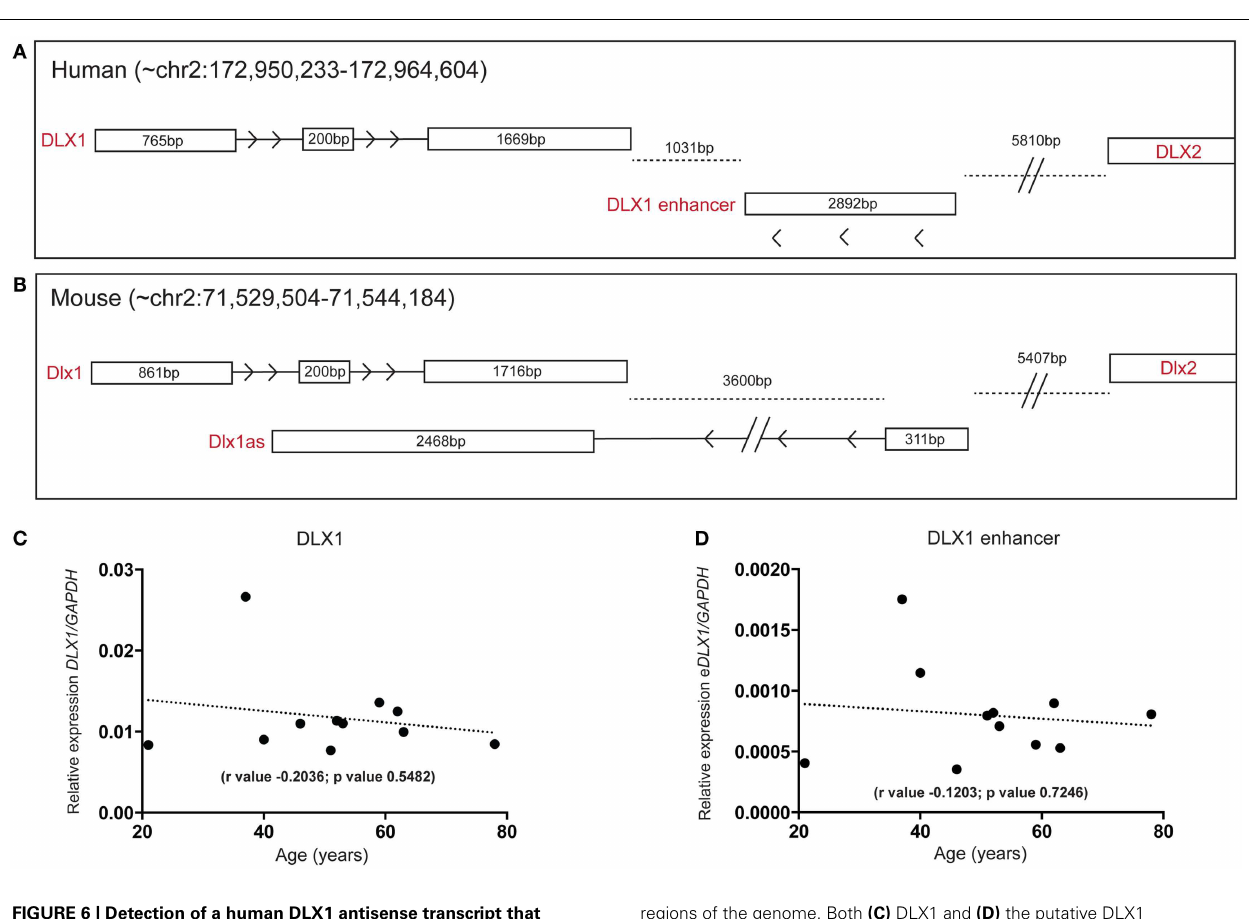
regions of the genome. Both (C) DLX1 and (D) the putative DLX1 enhancer transcript expression are predicted to remain relatively constant during aging in the human SEZ. (Significance is defined as p value <